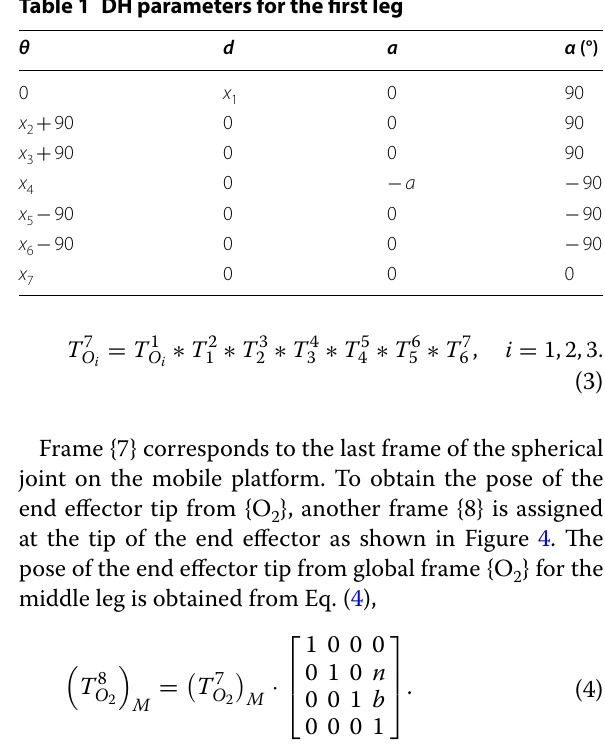
Table 1 DH parameters for the first